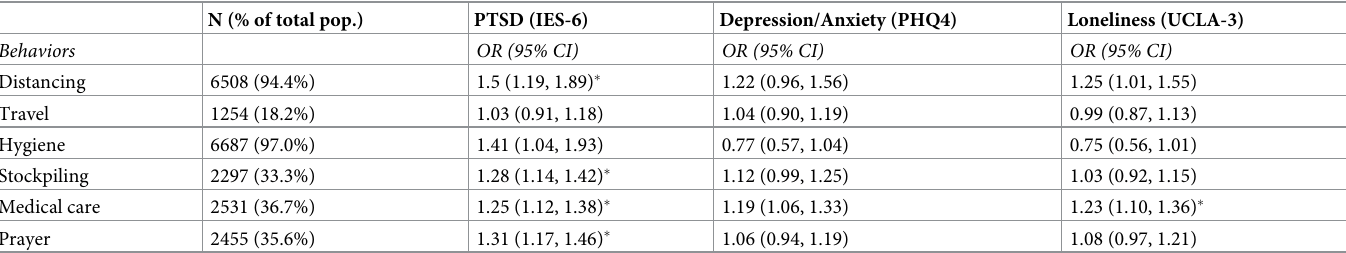
Table 4. Results of logistic regression models for elevated symptoms of PTSD, depression/anxiety, and loneliness in relation to the six COVID-19 behavior groups a . N (% of total